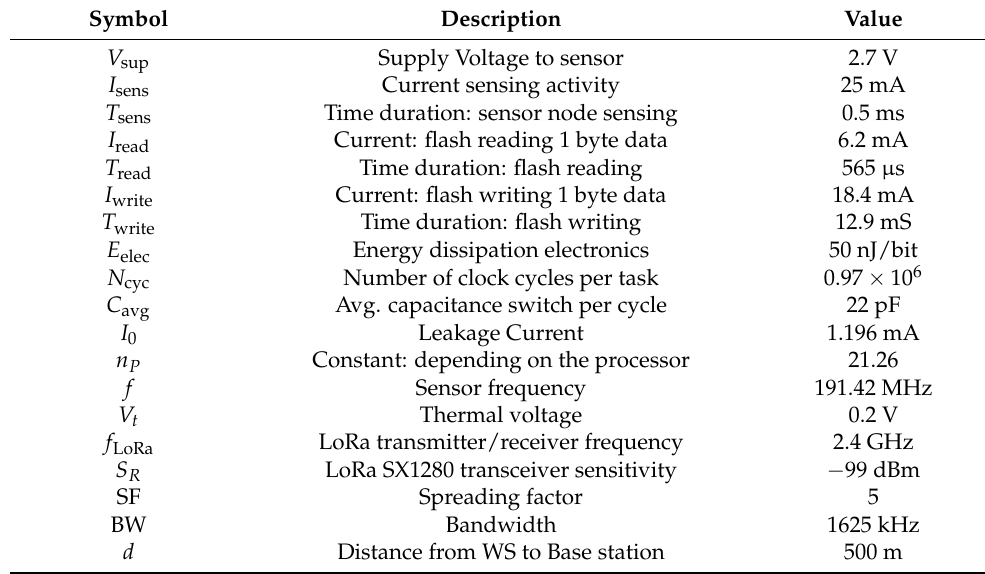
Table 3. Description and parameter values for assessing the energy cost of the WS